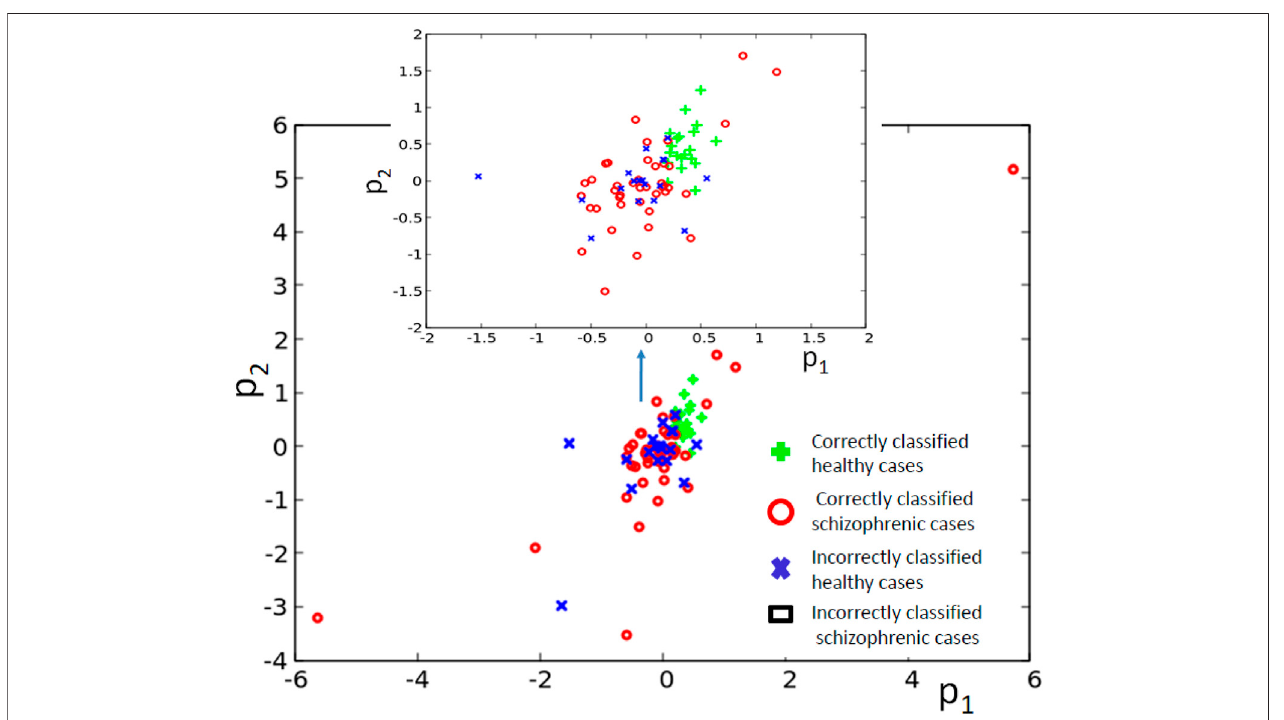
FIGURE 8 | The distribution of correctly and incorrectly classi fi ed cases for 4-oscillator network (cf. Figure 2B ) in the phase space ( p 1 , p 2 ).